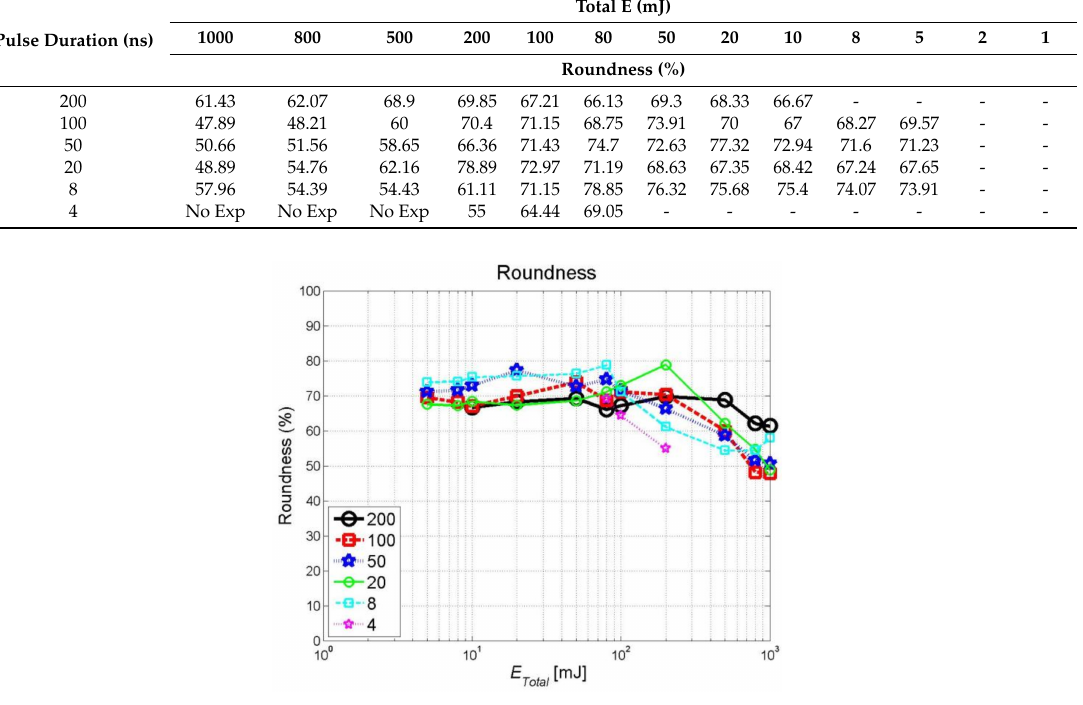
Figure 8. Roundness with the pulse duration from 4 ns to 200 ns. The roundness decreases as the E Total increases. This is because, with low E Total , the surface will be relatively flat and radiate transmitted heat symmetrically. However, with high E Total , the molten portion of the material will become larger and the molten surface will be relatively rugged, resulting in an asymmetric heat